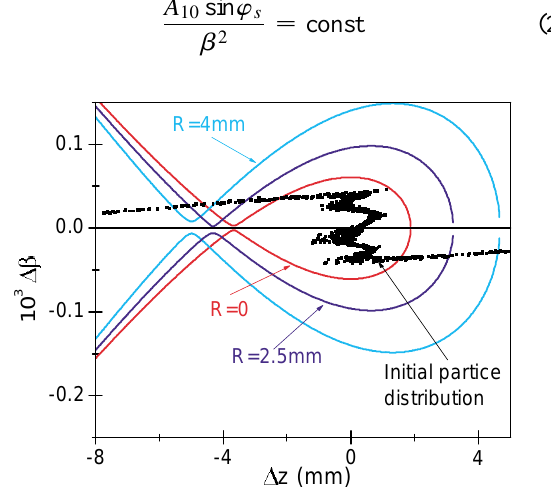
FIG. 2. (Color) Initial particle distribution and separatrices of the longitudinal motion calculated for different amplitudes of transverse oscillations at the injection velocity b (cid:1) 0.005 07